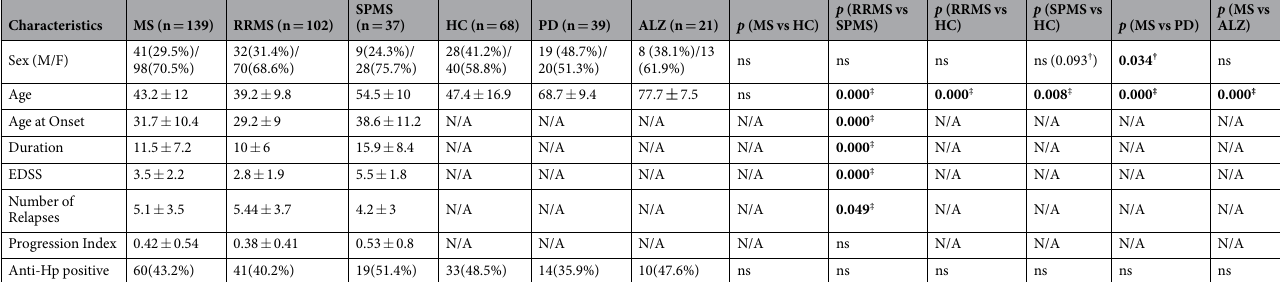
Table 1. Major demographic and clinical characteristics of 139 patients with multiple sclerosis (MS), including 102 with relapsing remitting MS (RRMS) and 37 with secondary progressive MS (SPMS); 68 healthy controls (HC), 39 patients with Parkinson’s disease (PD) and 21 patients with Alzheimer’s disease (ALZ) were also tested. Data represent mean ± standard deviation. † p-values were calculated using Pearson Chi-Square or Fisher’s Exact Test (2-sided). ‡ p-values were calculated using 2-tailed t-test for Equality of Means, equal variances were not assumed. p-values < 0.05 are shown in bold; p-values with a statistical tendency ( < 0.1) are also